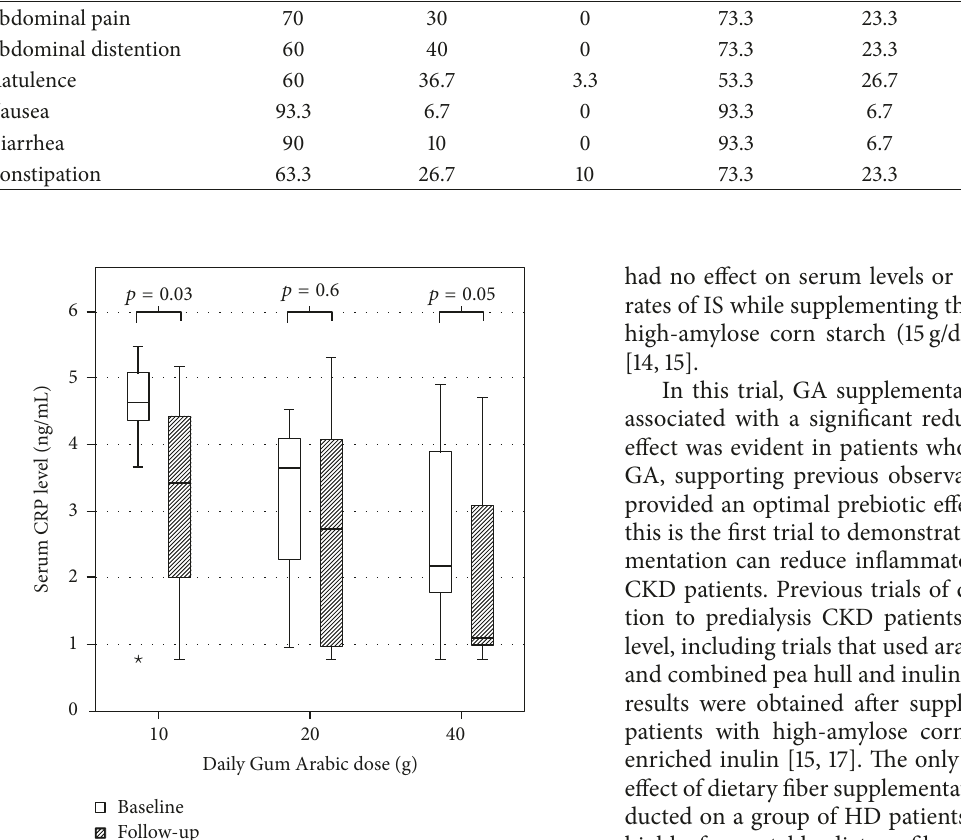
Table 4: The severity of gastrointestinal symptoms at baseline and at follow-up among studied chronic kidney disease patients ( 𝑛 = 30 ). Symptom